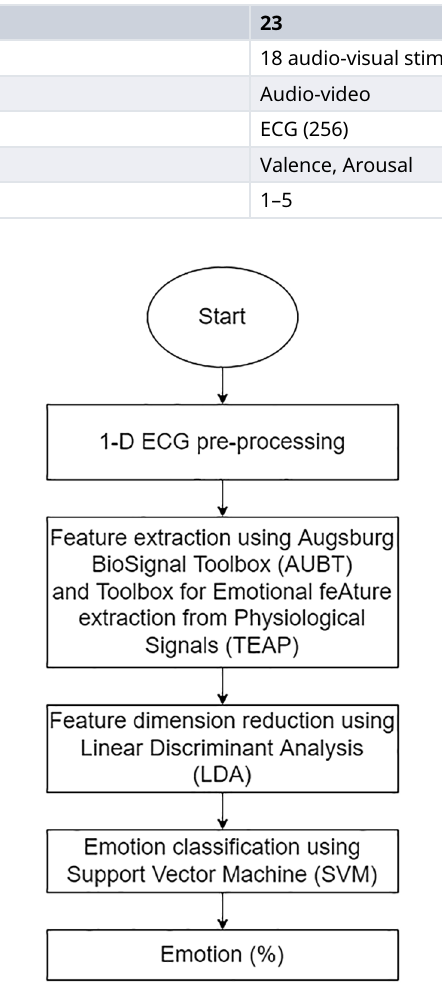
Figure 3. The overall structure of 1-D ECG-based